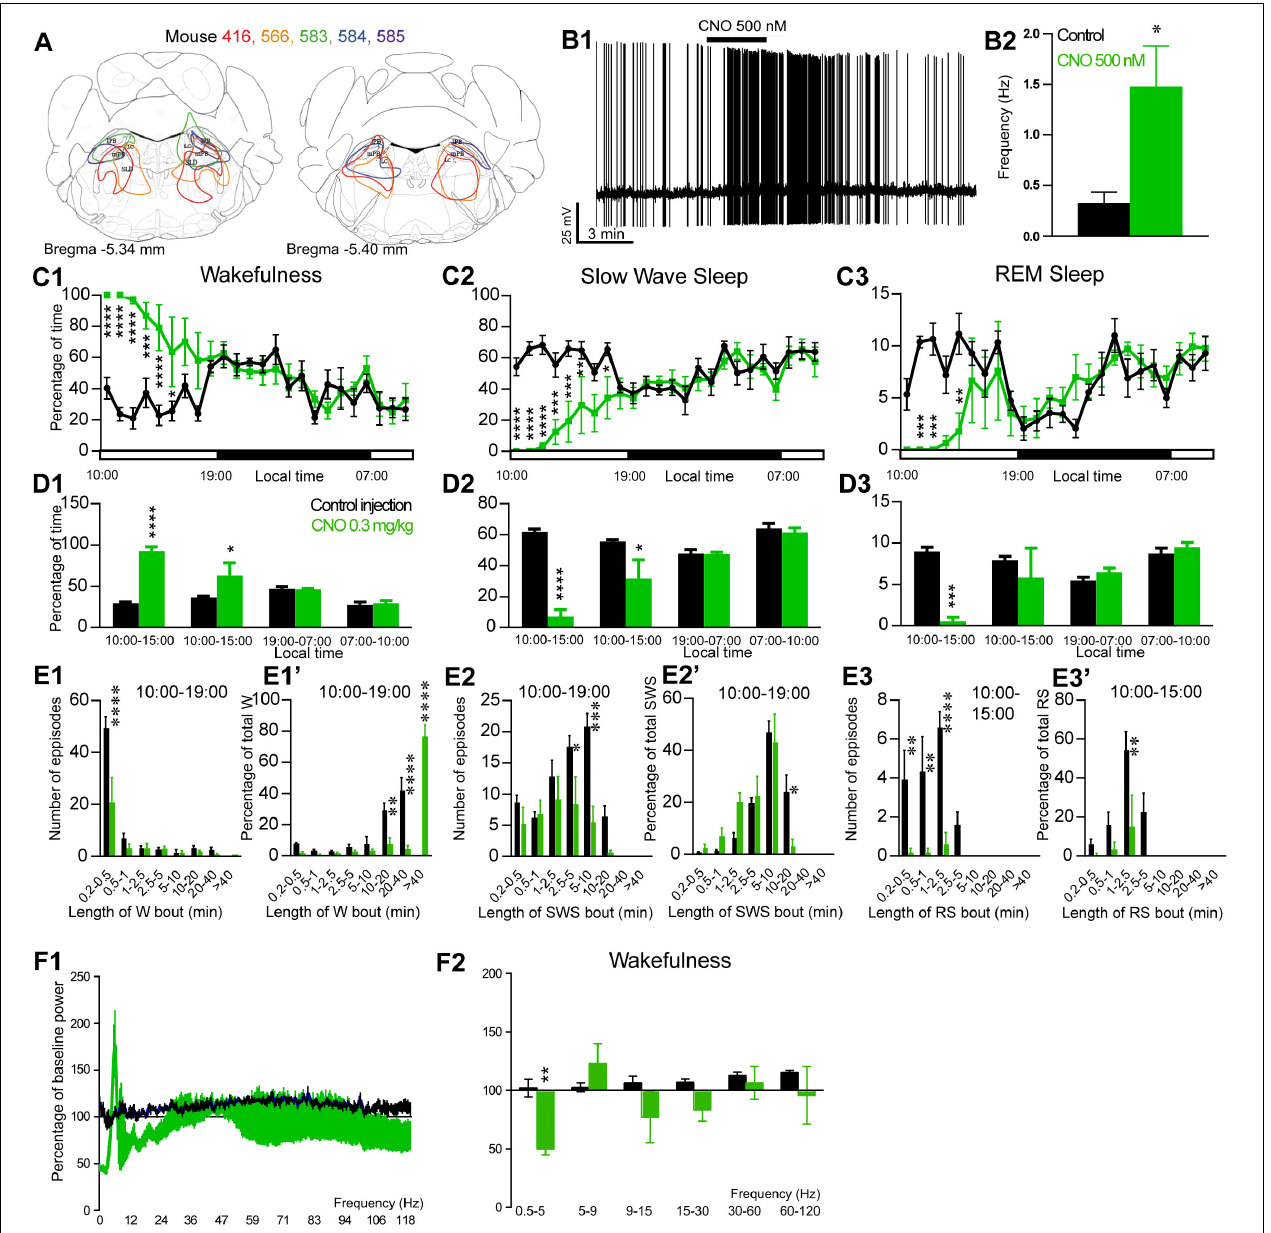
FIGURE 4 | Activation of PB glutamatergic neurons during the inactive period (10:00 or ZT3). (A) Extent of transduced neurons (mCherry-positive somas) is shown for individual Vglut2-IRES-cre mice that received bilateral injections of hM3Dq-mCherry-AAV into the PB (PB Vglut2 − hM3Dq ). (B1) PB Vglut2 − hM3Dq whole-cell recording showing an increase in firing frequency in response to bath application of CNO (0.5 µ M). (B2) Average firing frequency ( ± S.E.M.) during the last 2 min of CNO (0.5 µ M) application as compared with the 2 min period preceding CNO application (control; N = 6 PB Vglut2 − hM3Dq neurons). ∗ p < 0.05 Paired Student’s t -tests. (C) Hourly amount of wakefulness (C1) , SWS (C2) and REM (C3) sleep following CNO (0.3 mg/kg, N = 5 mice) as compared with control injection. (D1–D3) Percentage of sleep-wake states ( ± S.E.M.) during the 5 h post-injection period (10:00–15:00), the following 4 h of the light period (15:00–19:00), the subsequent 12 h dark/wake period (19:00–07:00) and first 3 h of the light period of the next day (07:00–10:00, N = 5 mice). (E1,E2) Number of episodes ( ± S.E.M.) of wakefulness (W) or SWS in each bout length and (E1’,E2’) time-weighted frequency histograms showing the proportion ( ± S.E.M.) of W or SWS amounts in each bout length as a percentage of the total amount of W or SWS during the 9 h post-injection period (10:00–19:00; N = 6). (E3) Number of episodes ( ± S.E.M.) of REM sleep (RS) in each bout length and (E3’) time-weighted frequency histograms showing the proportion ( ± S.E.M.) of RS amounts in each bout length as a percentage of the total amount of W or SWS during the 5 h post-injection period (10:00–15:00; N = 6). (F1) Wake power spectrum changes over baseline during the 3 h (10:00–13:00) post CNO (0.3 mg/kg, N = 5 mice) injection period as compared with control injection. (F2) Quantitative changes ( ± S.E.M.) in power for the δ (0.4–5 Hz), θ (5–9 Hz), α (9–15 Hz), β (15–30 Hz), low γ (30–60 Hz) and high γ (60–120 Hz) frequency bands ( ± S.E.M.) following vehicle or CNO (0.3 mg/kg, N = 5 mice) administrations. Power spectral analysis was not performed for slow-wave-sleep and REM sleep due to the low amount of these vigilance stages. (C–F) Control injection in Black, CNO injection in green; ∗ p < 0.05, ∗∗ p < 0.01, ∗∗∗ p < 0.001, ∗∗∗∗ p < 0.0001, two-way ANOVA followed by a post hoc Bonferroni test.